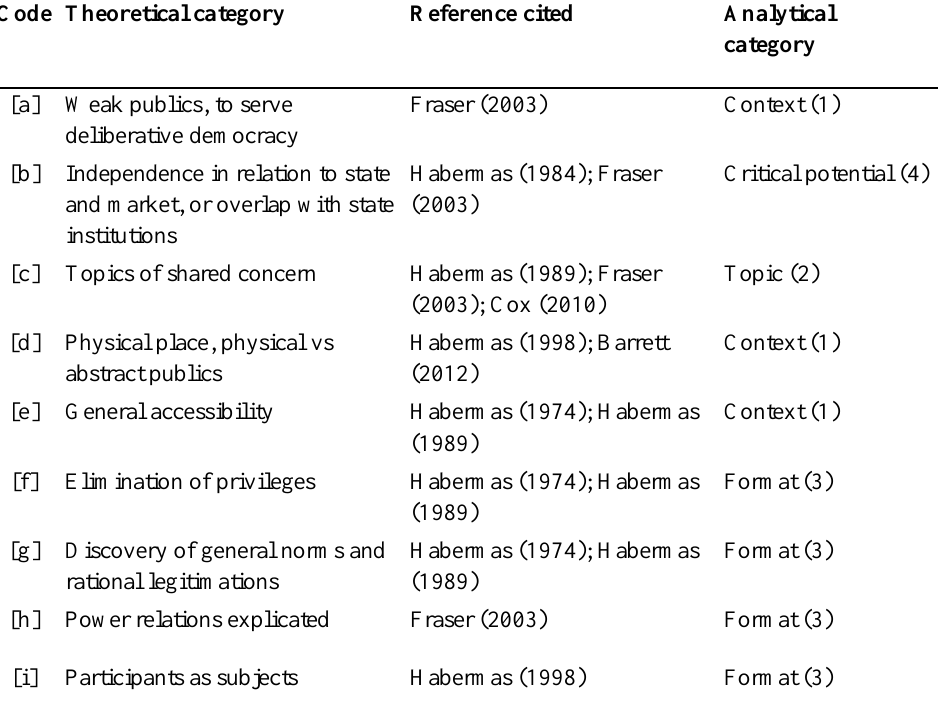
* Each theoretical category has a letter a-i, according to the order of appearance in the theory section. The theoretical categories are merged into analytical categories as displayed in the right